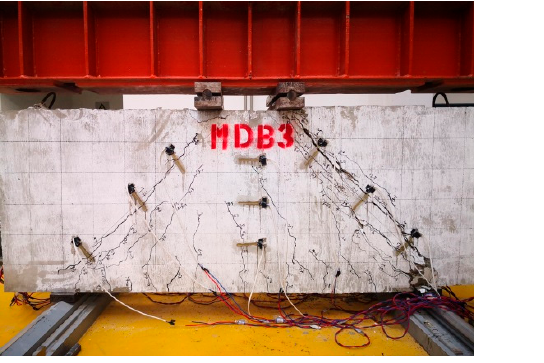
Figure 5. Surface concrete strain of test specimen MDB3.